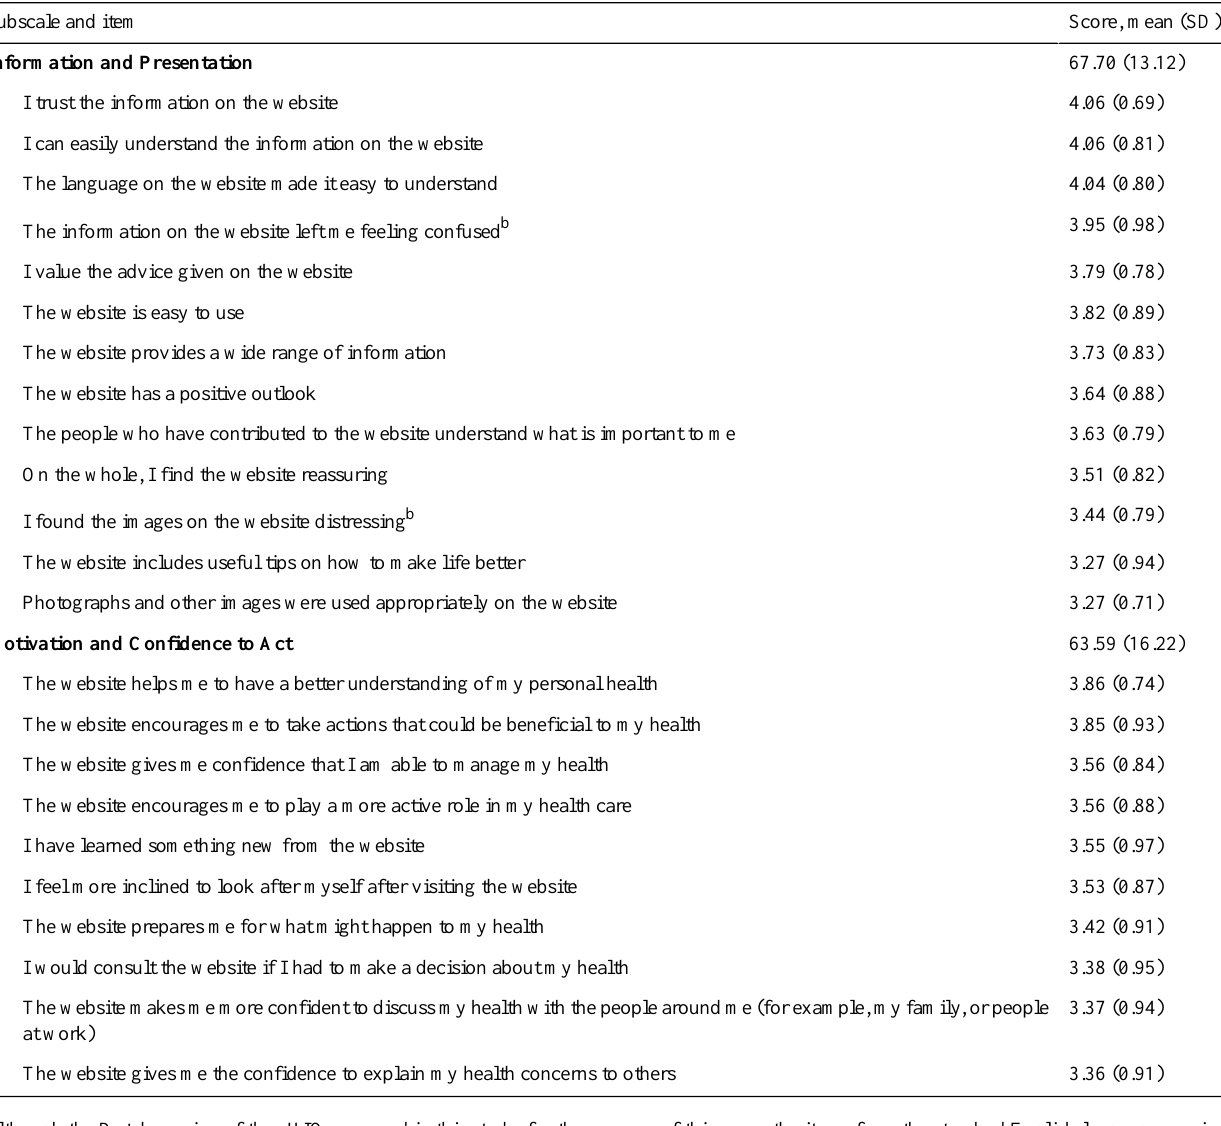
Table 1. Mean scores of the 2 subscales of the eHealth Impact Questionnaire (eHIQ)-Part 2 and the individual